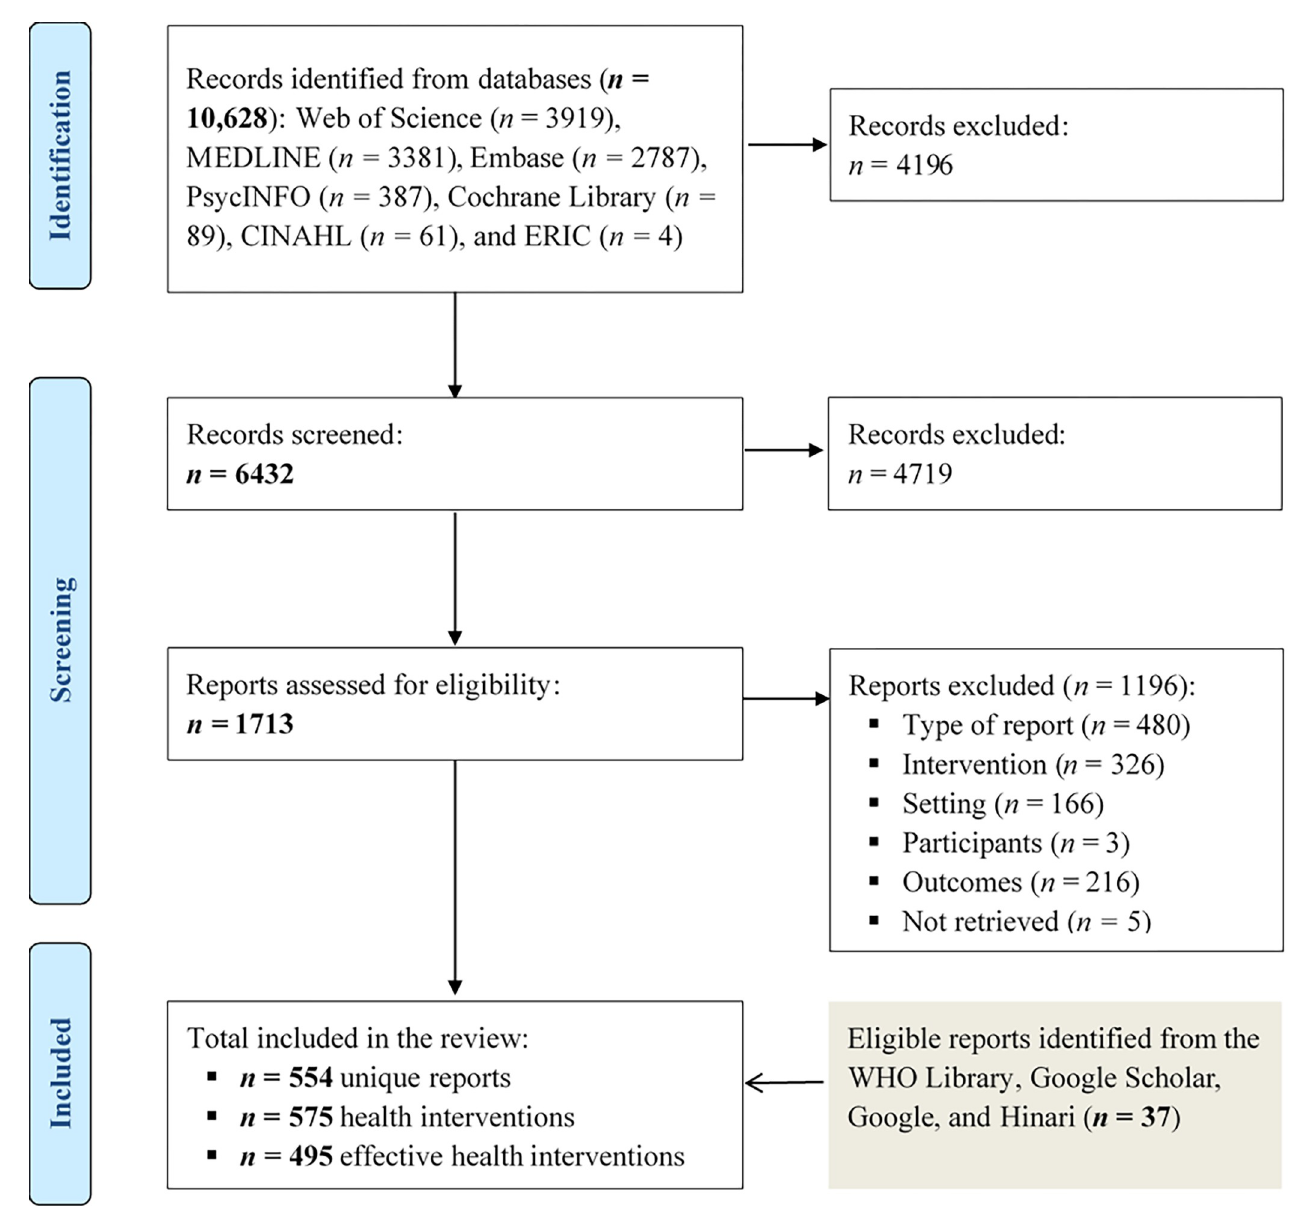
Fig 1. PRISMA 2020 flow diagram of the intervention inclusion